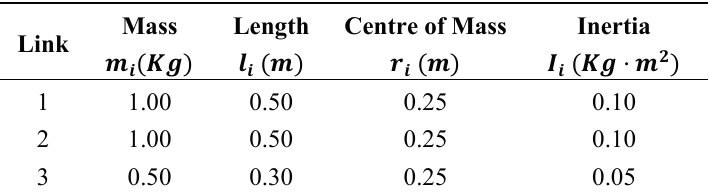
Table 1. Structural properties of a serial robotic manipulator.